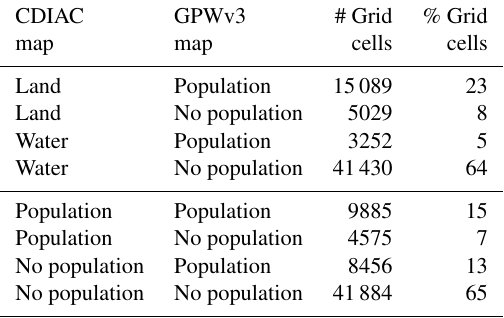
Table 1. Comparison of the year 1997 GPWv3 population map with CDIAC geography and fixed population maps. The number of wa- ter cells is less than 70% of the total because 4550 ocean cells sur- rounding Antarctica are labeled as the Antarctic Fisheries, a United- Nations-named unit used to track energy consumption of Southern Ocean fishing fleets. CDIAC considers these Antarctic Fisheries cells as pseudo land cells (i.e., subject to emitting FFCO2). The year 2010 LandScan population map has a similar comparison to the CDIAC geography map (within 3% in all categories) and pop- ulation map (within 4% in all categories). CDIAC, GPWv3, and LandScan population maps all have land cells that are not popu-